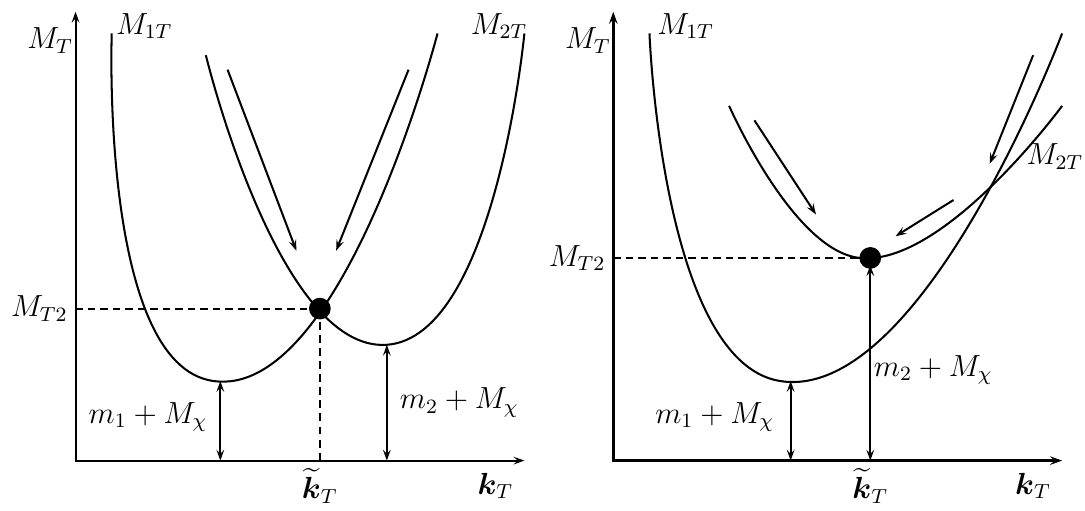
Figure 1 . Schematic pictures of M T 2 for the balanced (left) and the unbalanced (right) configura- tions of transverse masses. The black dot in each plot corresponds to the M T 2 value obtained by min- imization over the invisible particle momenta k T , and e k T is the solution (or the minimizer) of M T 2